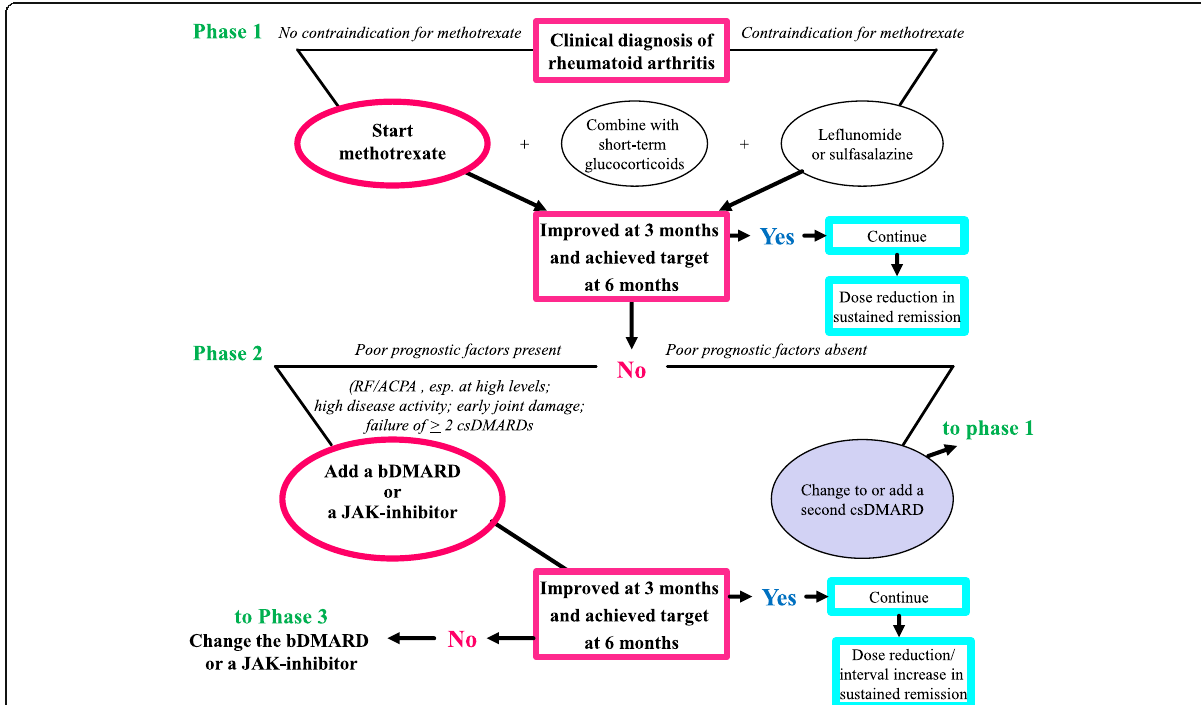
Fig. 2 EULAR recommendations for the management of rheumatoid arthritis with synthetic and biological DMARDs: 2019 update. Modified from reference